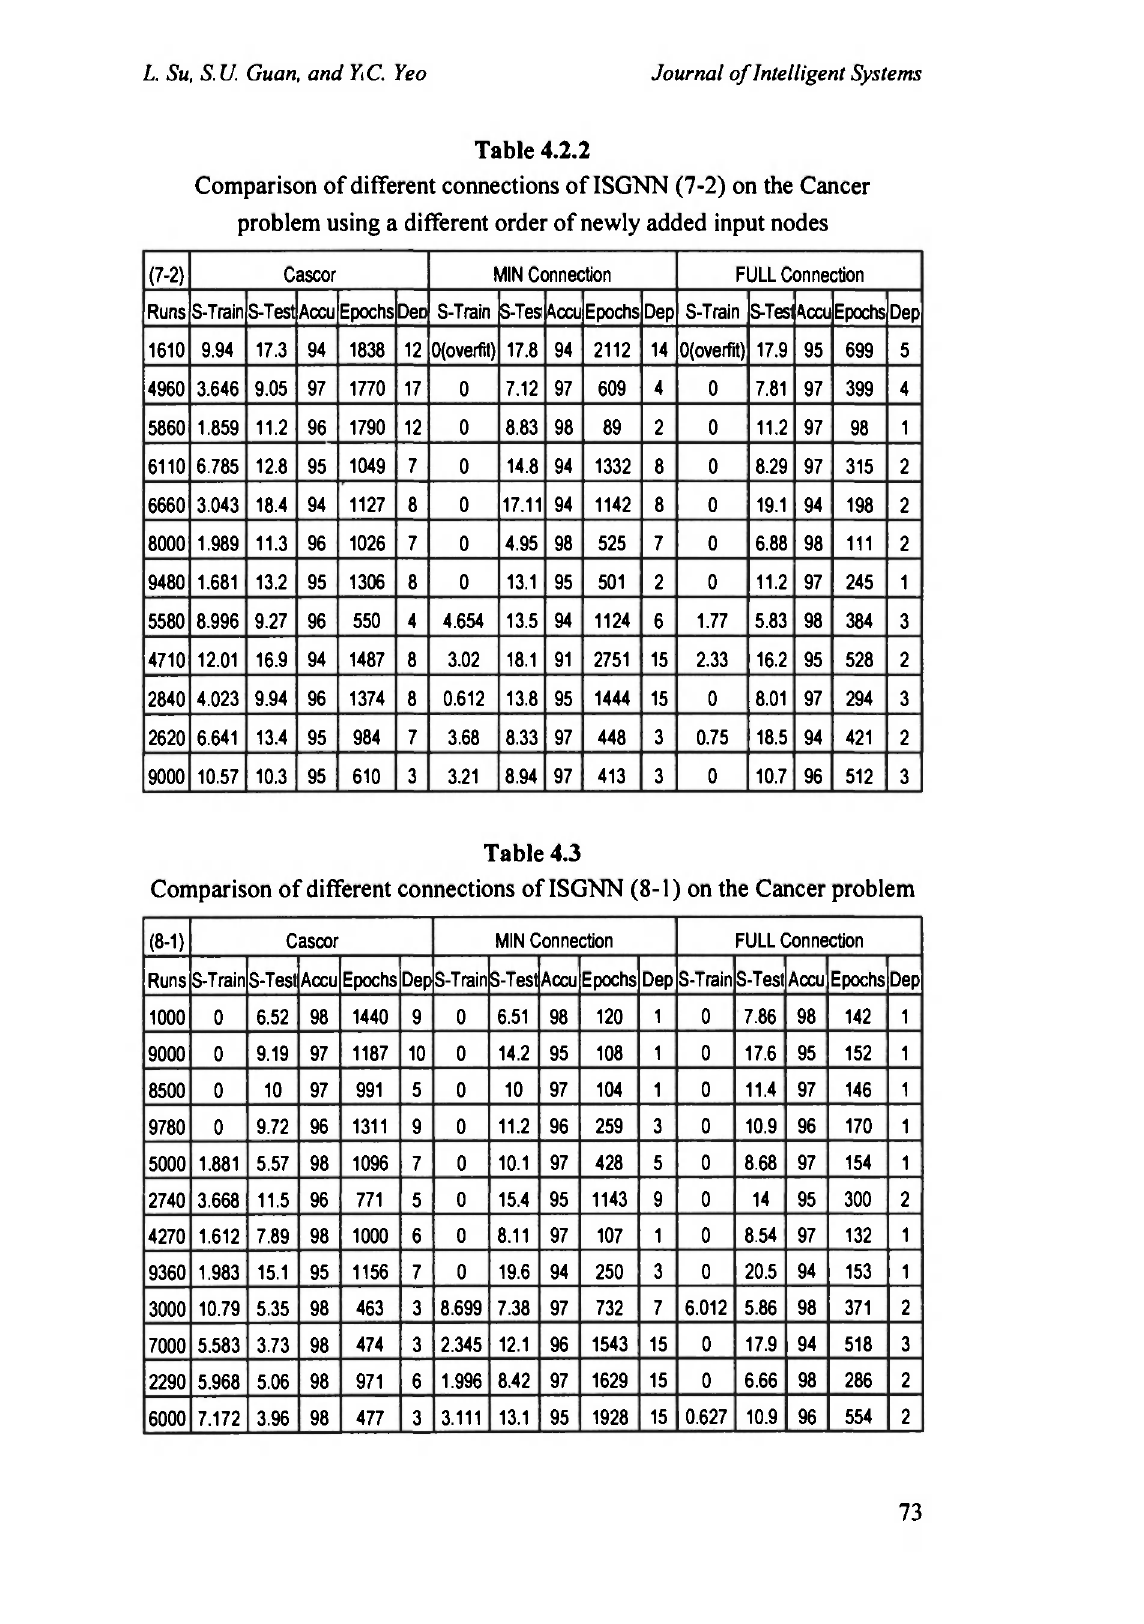
Comparison of different connections of ISGNN (7-2) on the Cancer problem using a different order of newly added input nodes MIN Connection FULL Connection